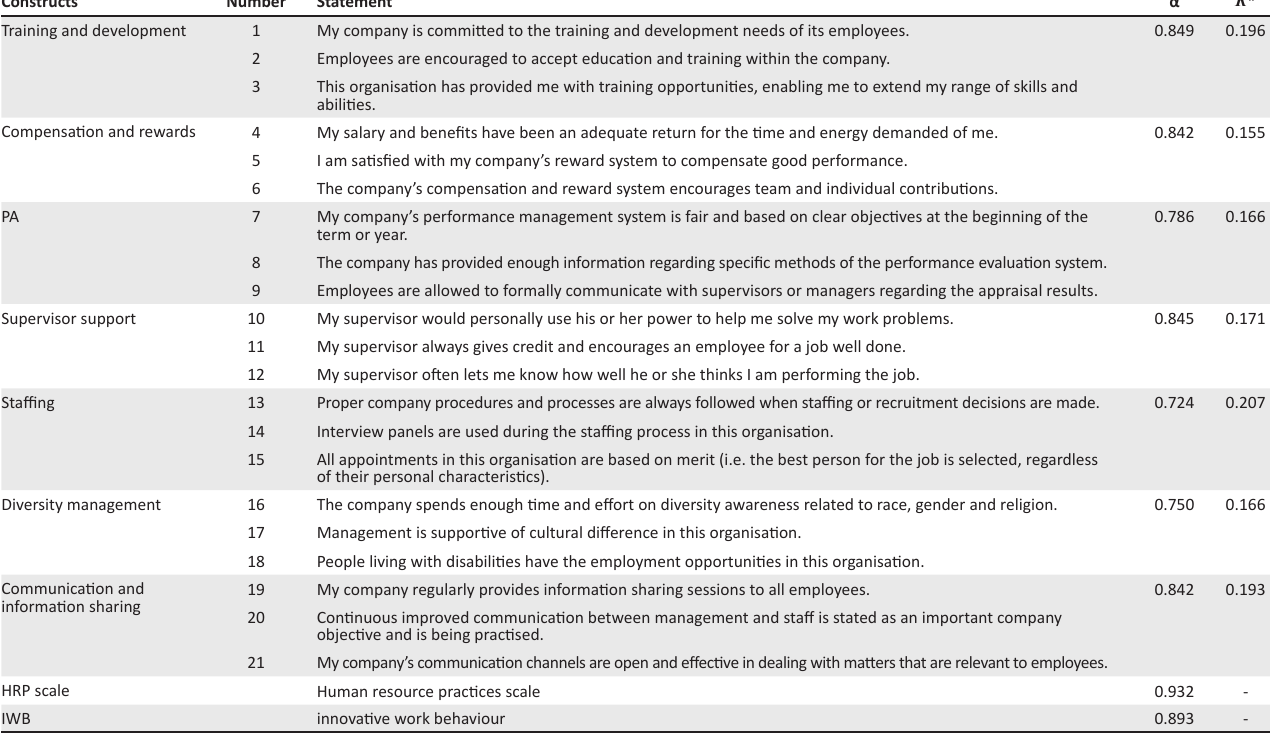
TABLE 1: Constructs, items of the human resource practice scale, reliability coefficients and correlations between constructs and innovation. Constructs Number Statement